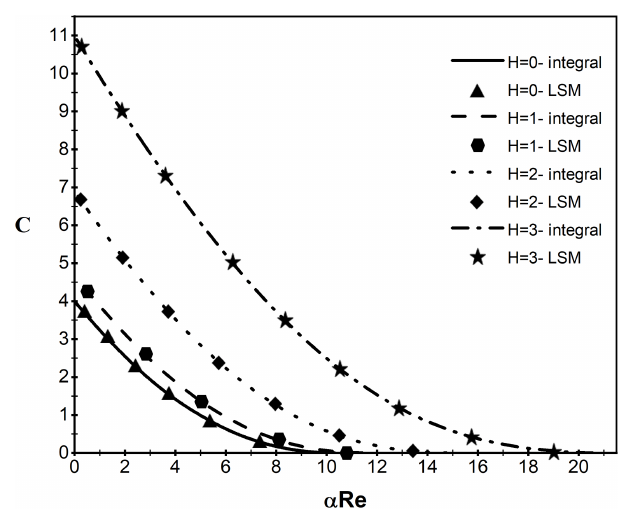
Figure 3. Hartmann number effect on the C – α Re curve.